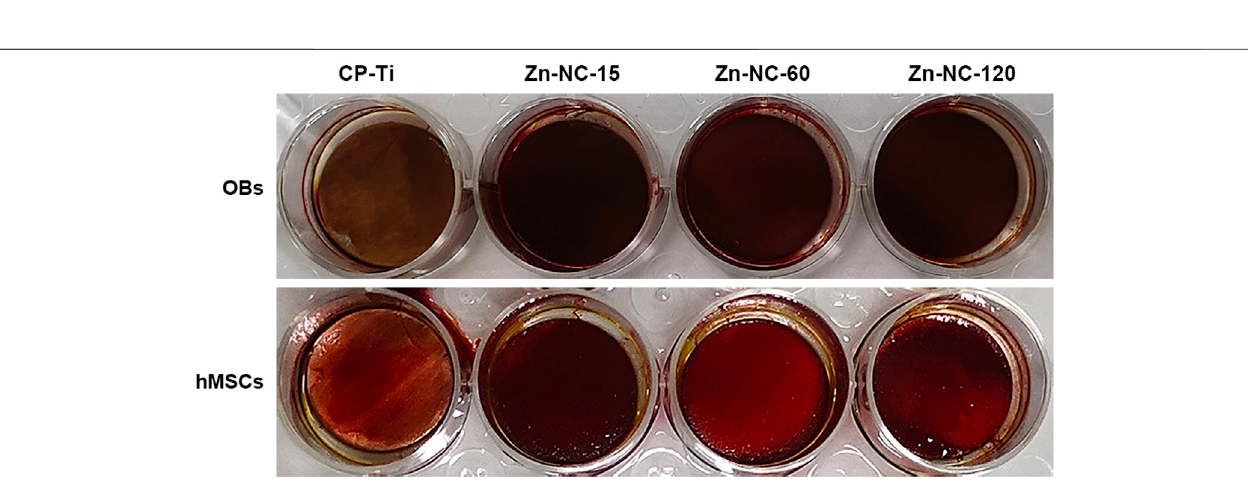
Frontiers in Materials |